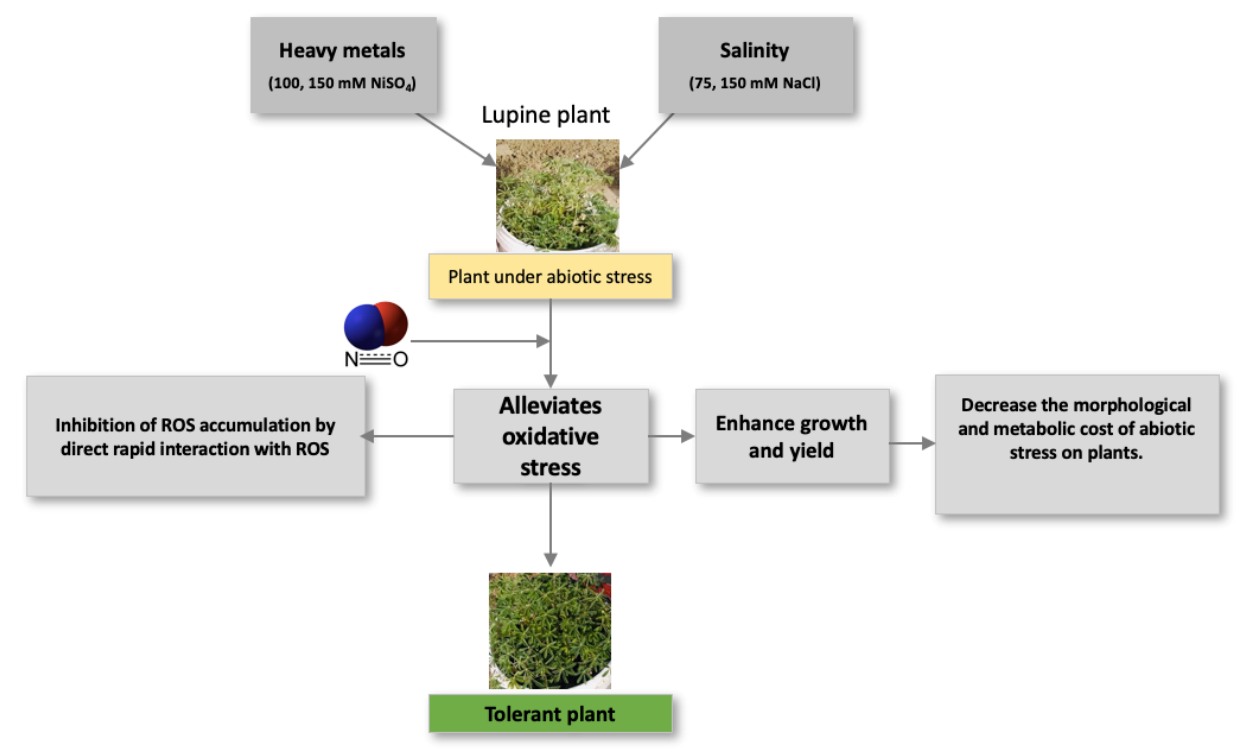
Figure 4 The model of response of lupine plants under abiotic stress to exogenous nitric oxide